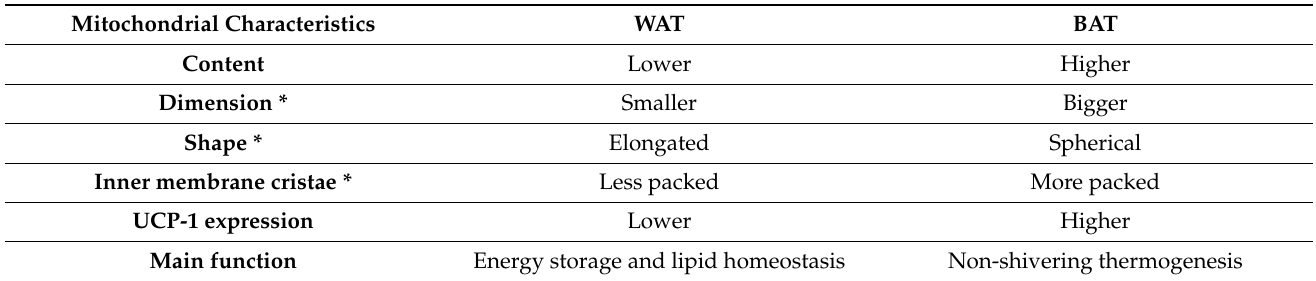
Table 1. WAT and BAT